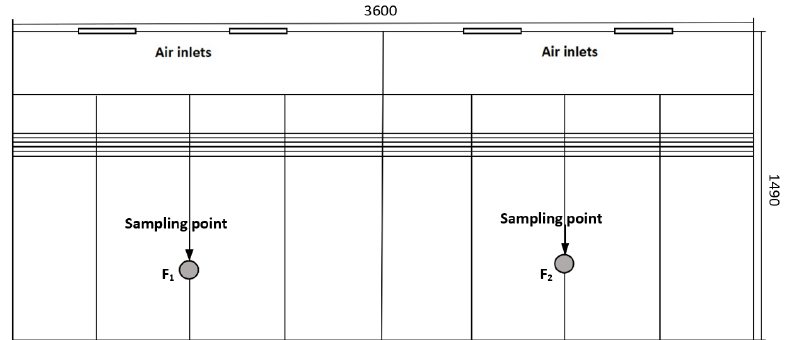
Figure 5. Sampling points in the piggery.